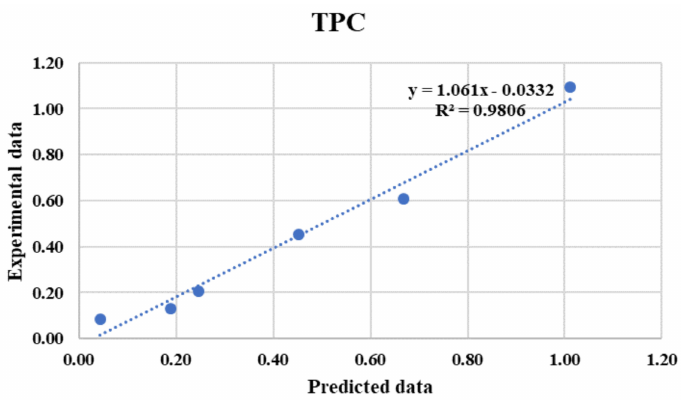
Figure 3. Predicted TPC values of strawberries using artificial neural networks (ANNs) versus experimental values for testing dataset.